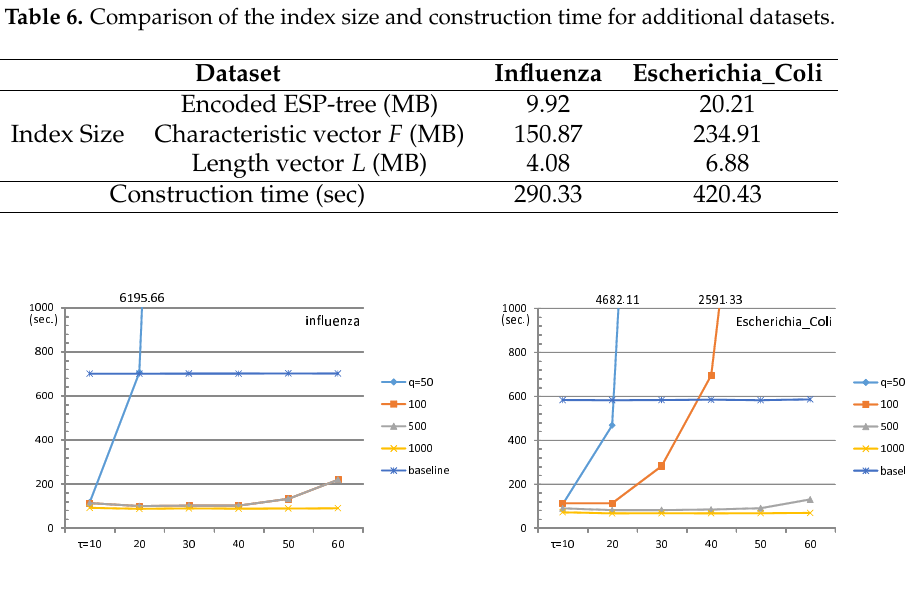
Figure 8. Search time (sec.) for repetitive texts: E. coli ( left ) and influenza ( right